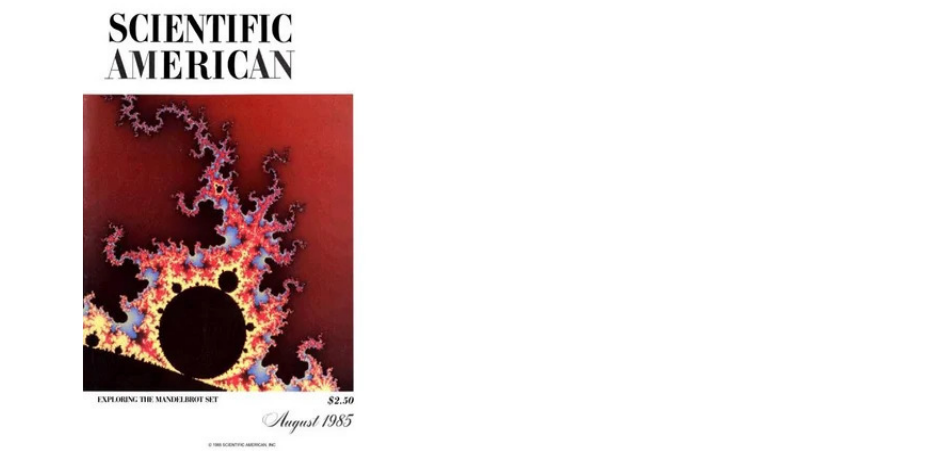
Figure 16. First fractal art image: Cover page Scientific American (August, 1985), available from https://www.scientificamerican.com/magazine/sa/1985/08-01/ (accessed on 20 October 2021).